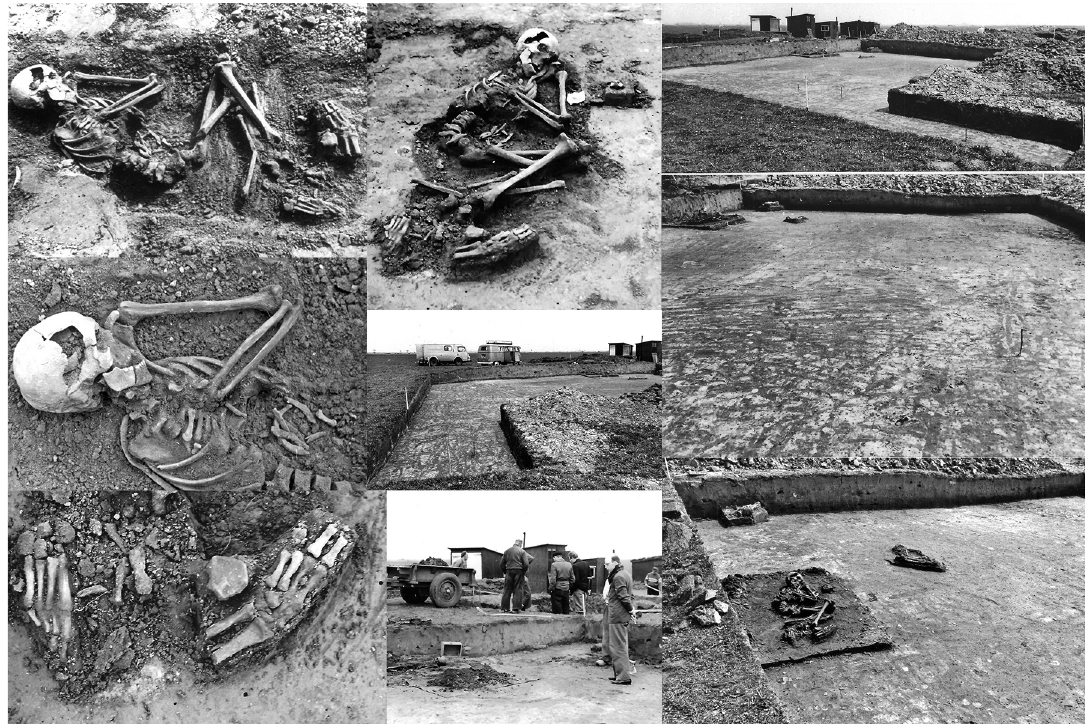
Figure 2: Selection of photographs taken of burial 228 during